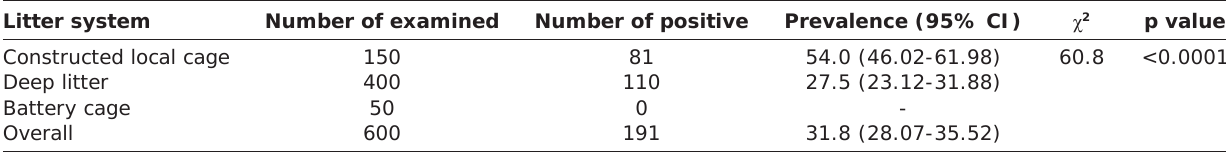
Table-4: Prevalence of coccidiosis according to litter systems in Maiduguri metropolis, Northeastern Nigeria. Litter